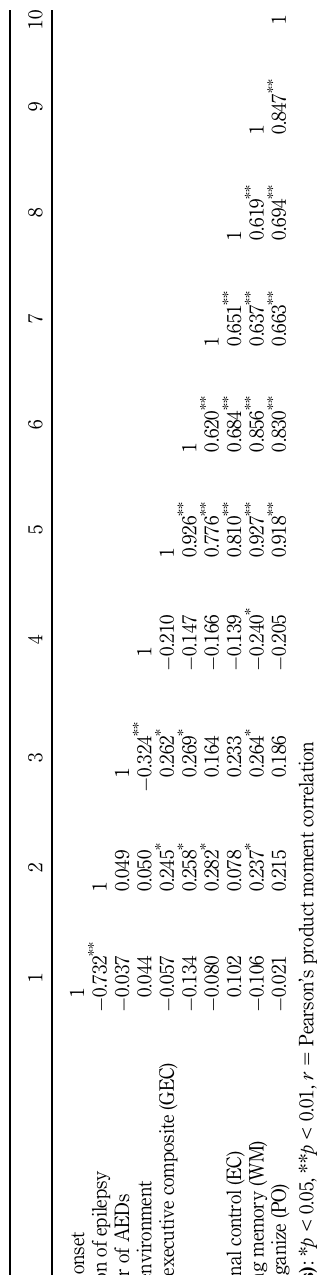
among age at seizure onset, duration of epilepsy, number of AEDs, home environment and subscales of